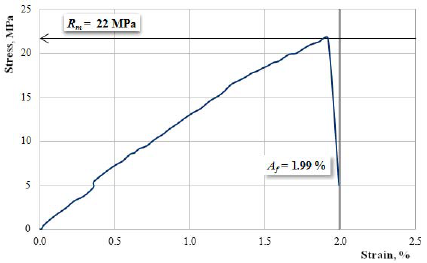
Figure 4. The characteristic curve of a Dammar-based resin sample.